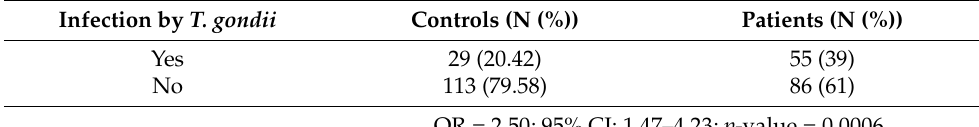
Table 3. Frequency of T. gondii infection in patients and controls. Infection by T. gondii Controls (N